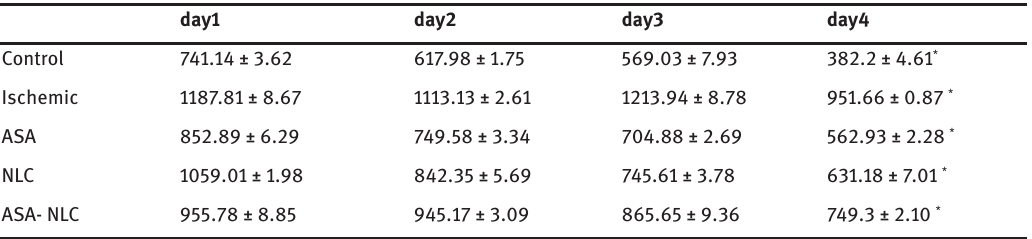
Table 1: The distance spent to locate the hidden platform for intragroup comparisons in each groups (cm).